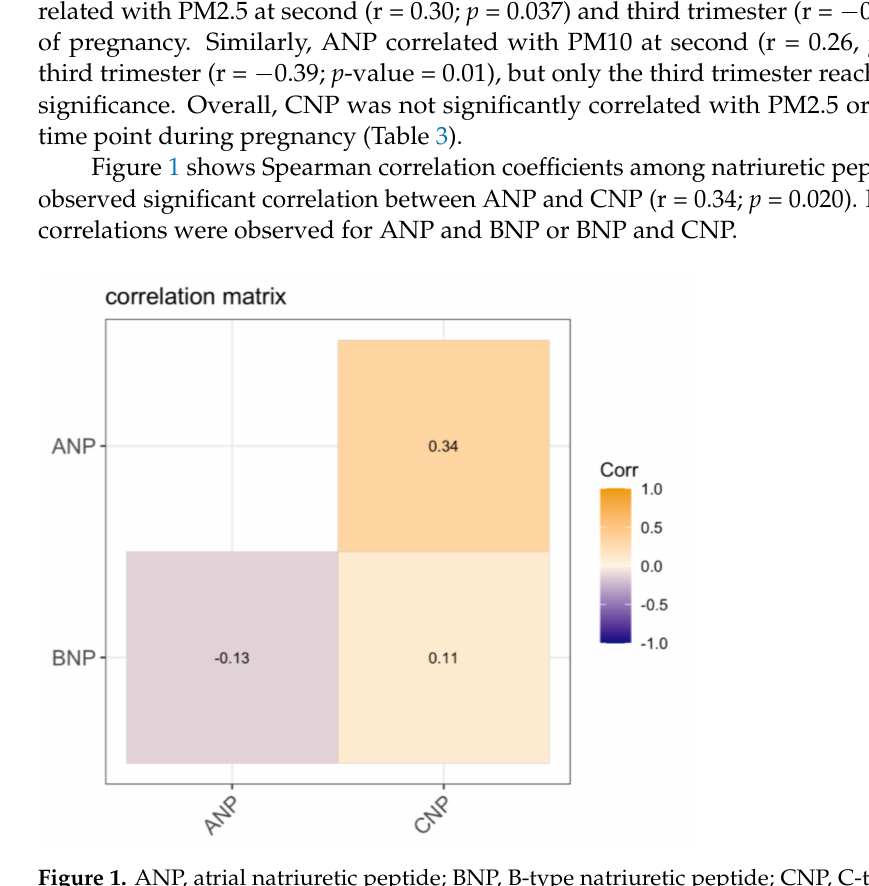
Figure 1. ANP, atrial natriuretic peptide; BNP, B-type natriuretic peptide; CNP, C-type natriuretic peptide. Values represent spearman correlation coefficients. Only the ANP and CNP correlation was statistically significant ( p = 0.020). No significant correlations ( p > 0.05) were found for ANP and BNP or BNP and